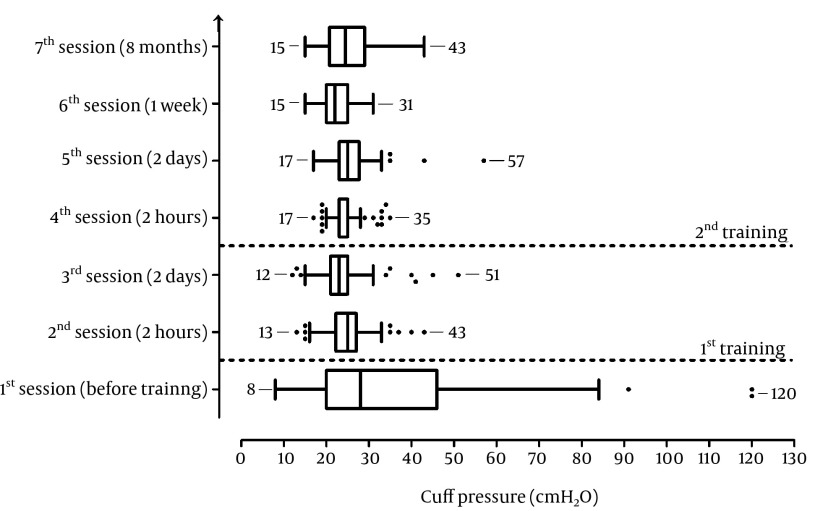
Box and whisker plot of median endotracheal cuff tube pressure (cmH2O) before and after training sessions measured by cuff manometry in the different periods of adjustment of cuff pressure by hand touching of ICU nurse training